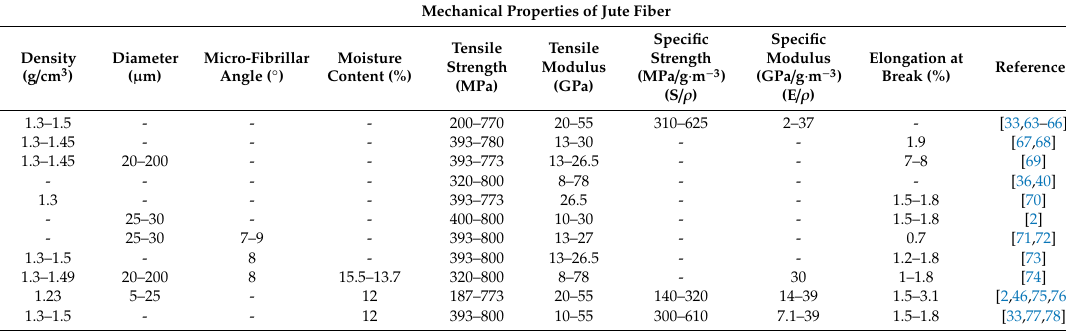
Figure 3. Showing tensile strength comparison of treated and untreated jute composite. Table 2. Mechanical properties of jute fiber.